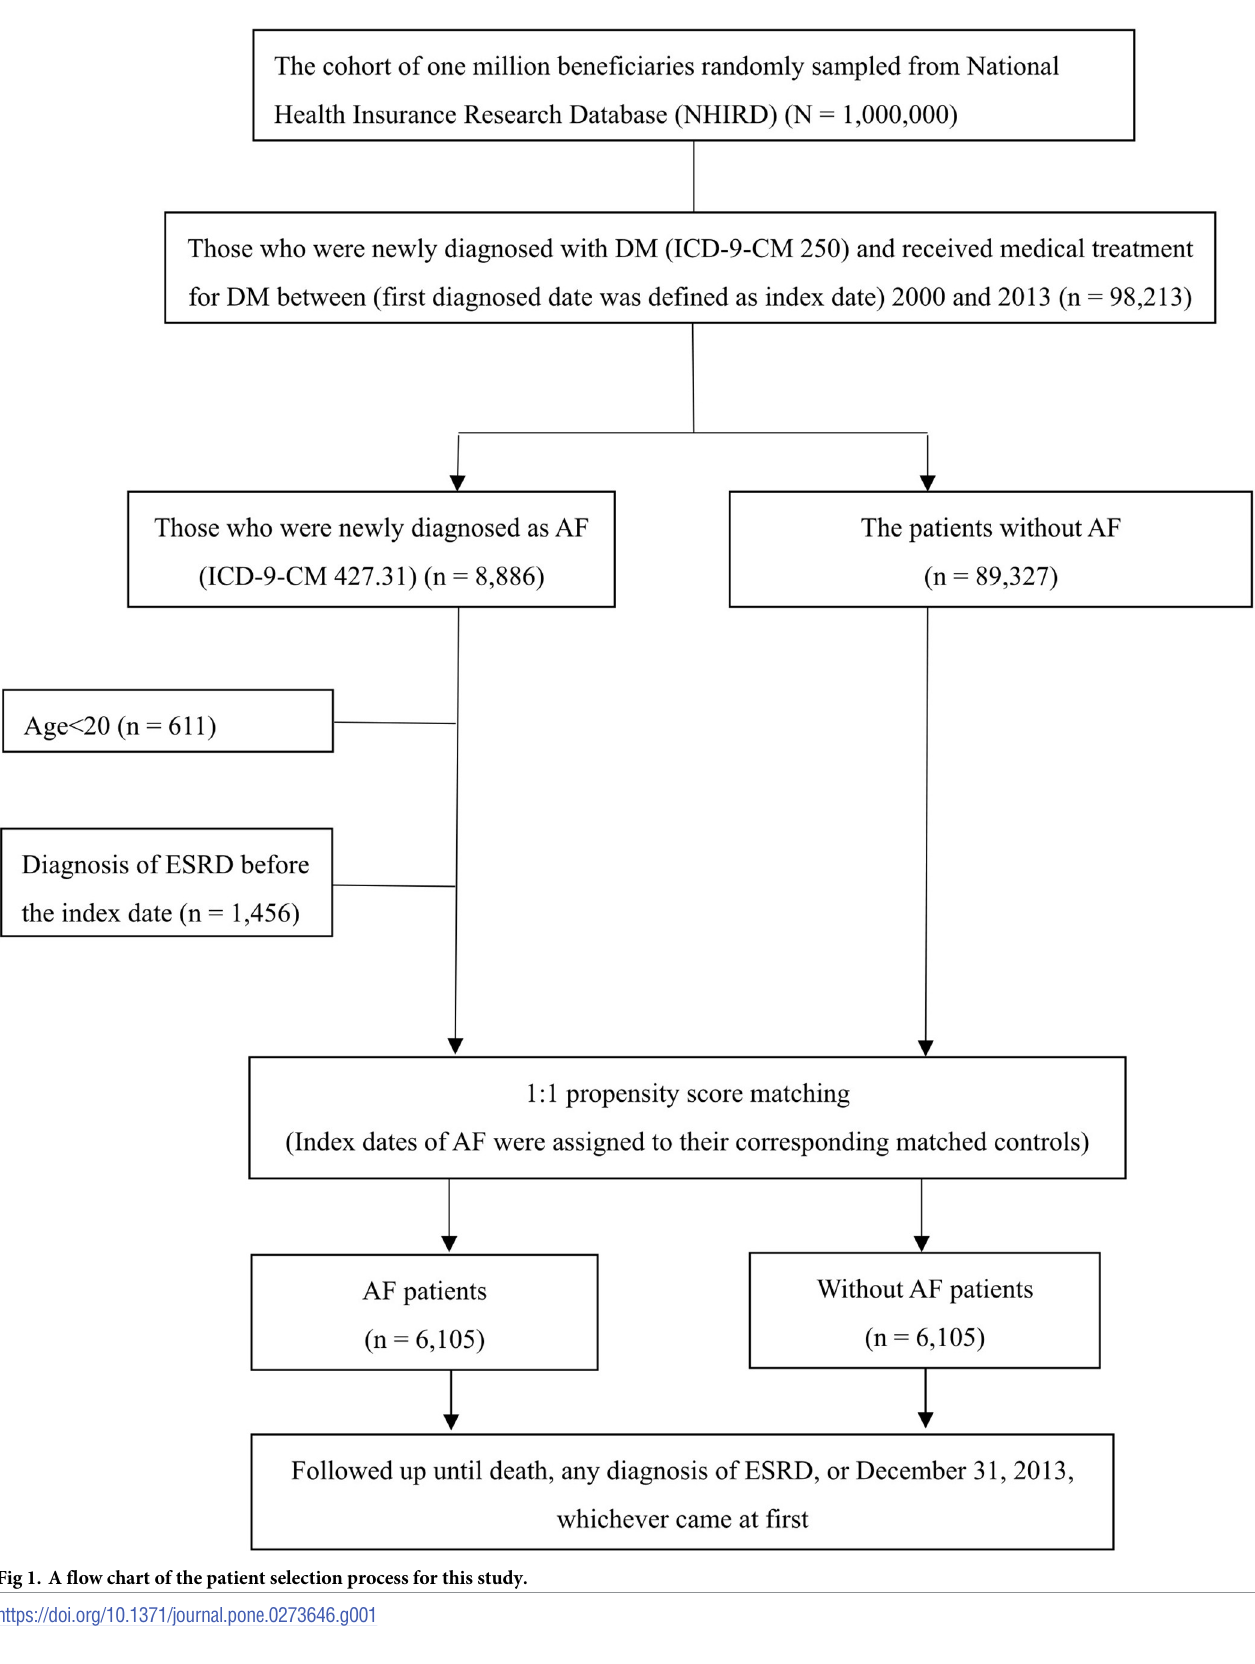
PLOS ONE | https://doi.org/10.1371/journal.pone.0273646 August 26, 2022 4 /